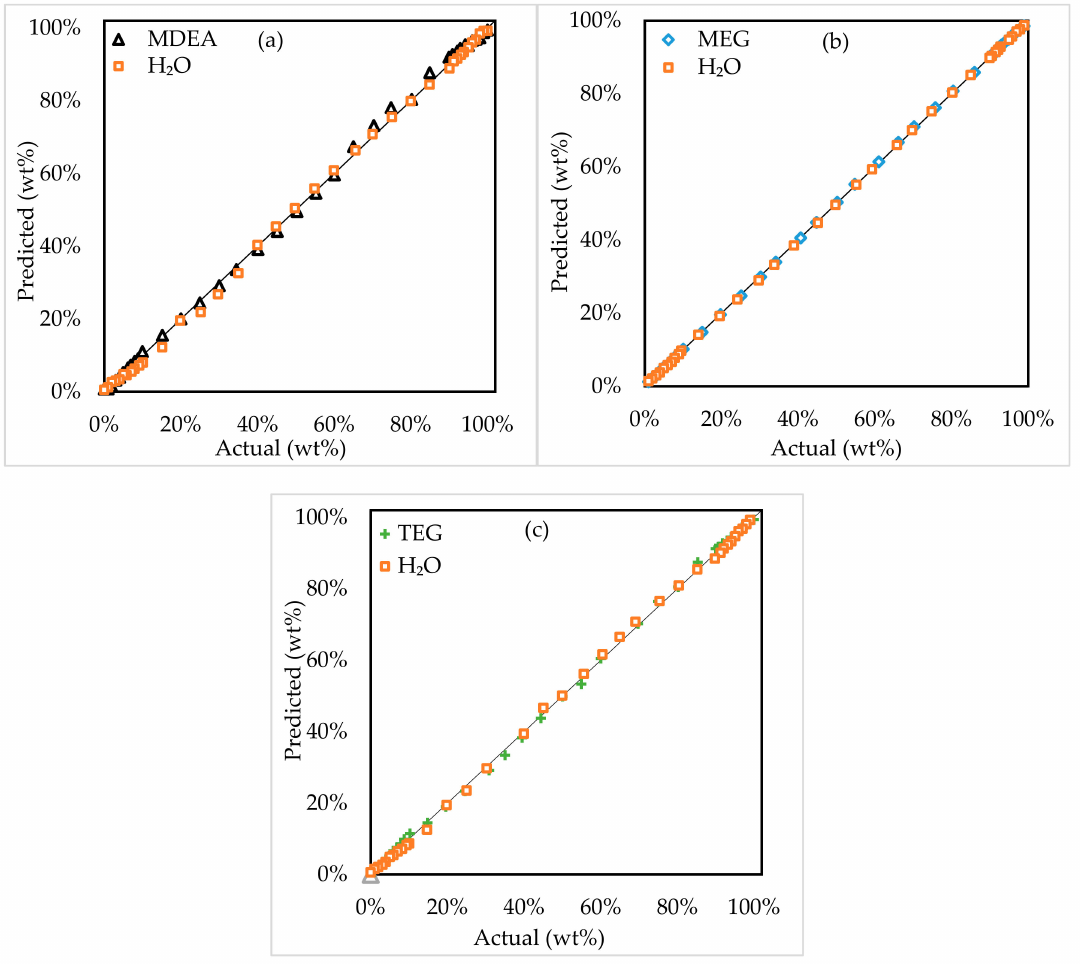
Figure 3. Actual vs. predicted values of two-component systems; the MDEA-H 2 O system ( a ), MEG-H 2 O system ( b ), and TEG-H 2 O system ( c